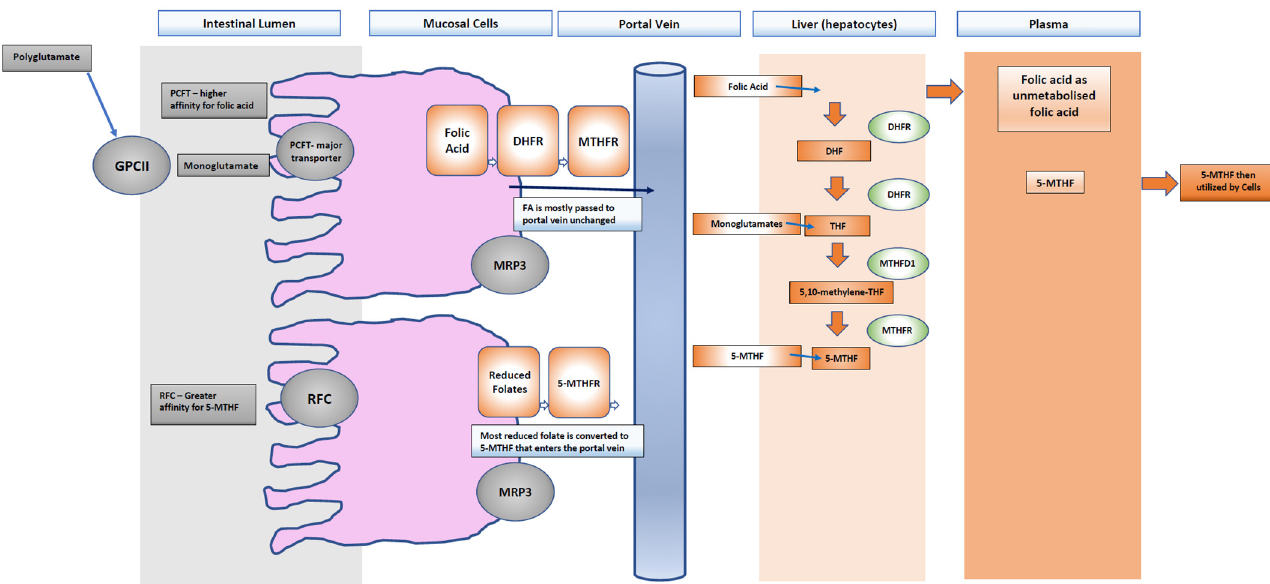
Figure 3. Polyglutamates are converted to monoglutamates by glutamate carboxypeptidase II GPCII and absorbed by the reduced folate carrier (RFC) or the proton-coupled folate transporter (PCFT). Almost all the reduced folates are converted into 5-MTHF and transported to the portal vein by multidrug resistance-associated protein 3 (MRP3) to the liver and blood. Folic acid is mostly passed unchanged to the portal vein, where it needs to be metabolized in the liver to dihydrofolate (DHF) by the enzyme dihydrofolatereductase (DHFR) and to tetrahydrofolate (THF) also by DHFR and finally to 5-methyltetrahdyrofolate (5-MTHF). What is not converted will pass into the plasma.